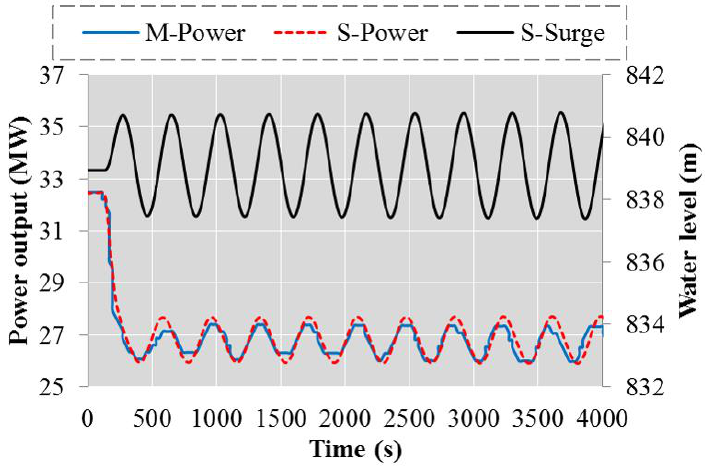
Figure 8. Simulation and measurement of the power oscillation under power control mode (Case